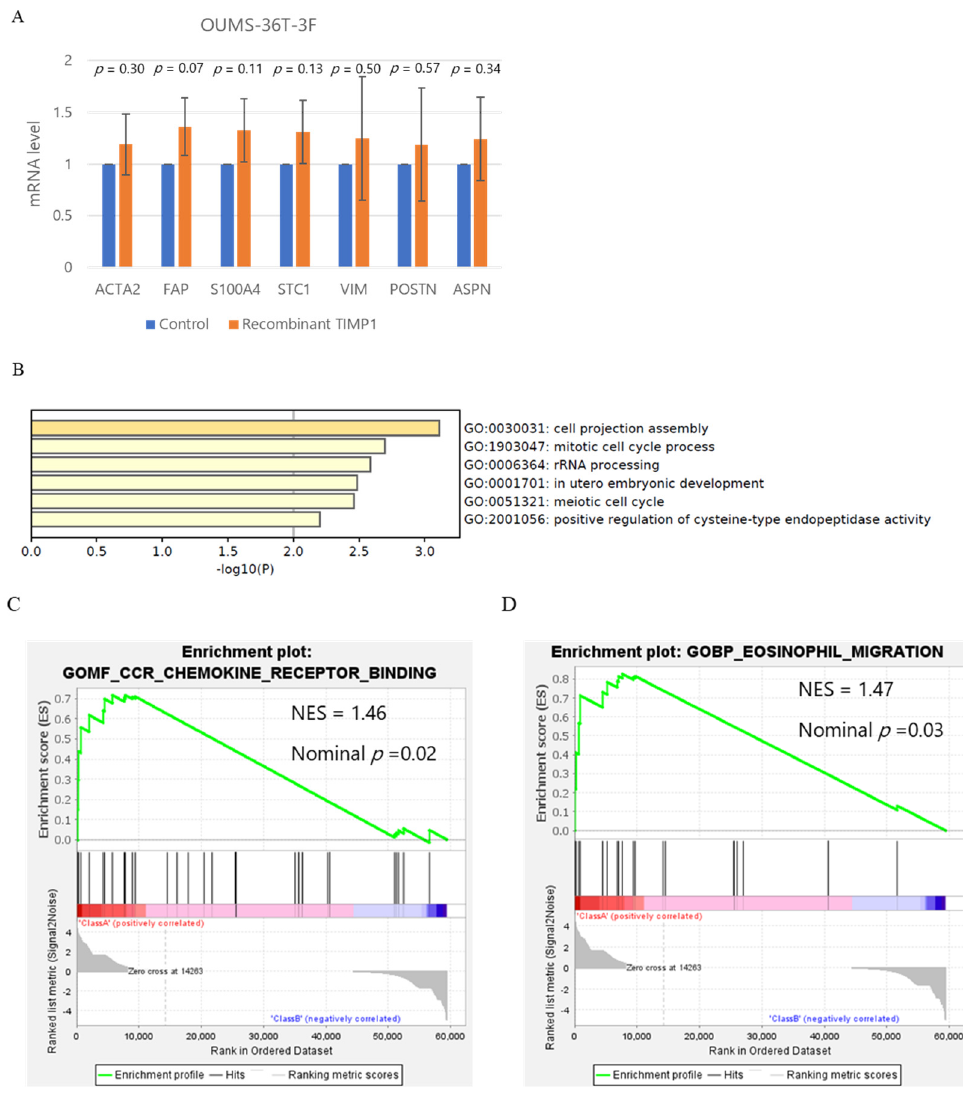
Figure 8. Gene expression in OUMS-36T-3F cells with or without recombinant TIMP1 (0.5 µg/mL). ( A ) q-PCR analysis of genes which are involved in cancer-associated fibroblast (CAF) formation. ( B ) Gene ontology analysis. ( C , D ) Gene set enrichment analysis (GSEA).